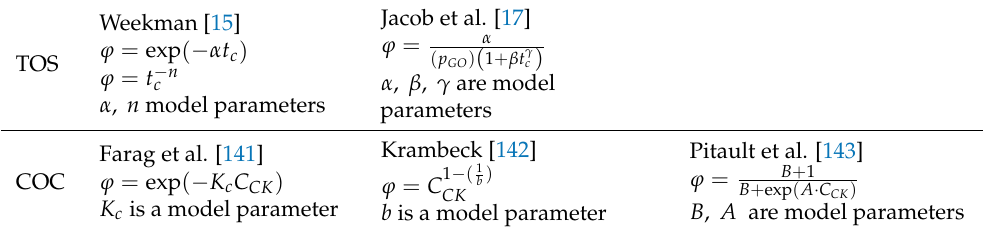
Table 7. Summary of types of deactivation catalysts used in the literature (Redrawn from [7]). Weekman TOS